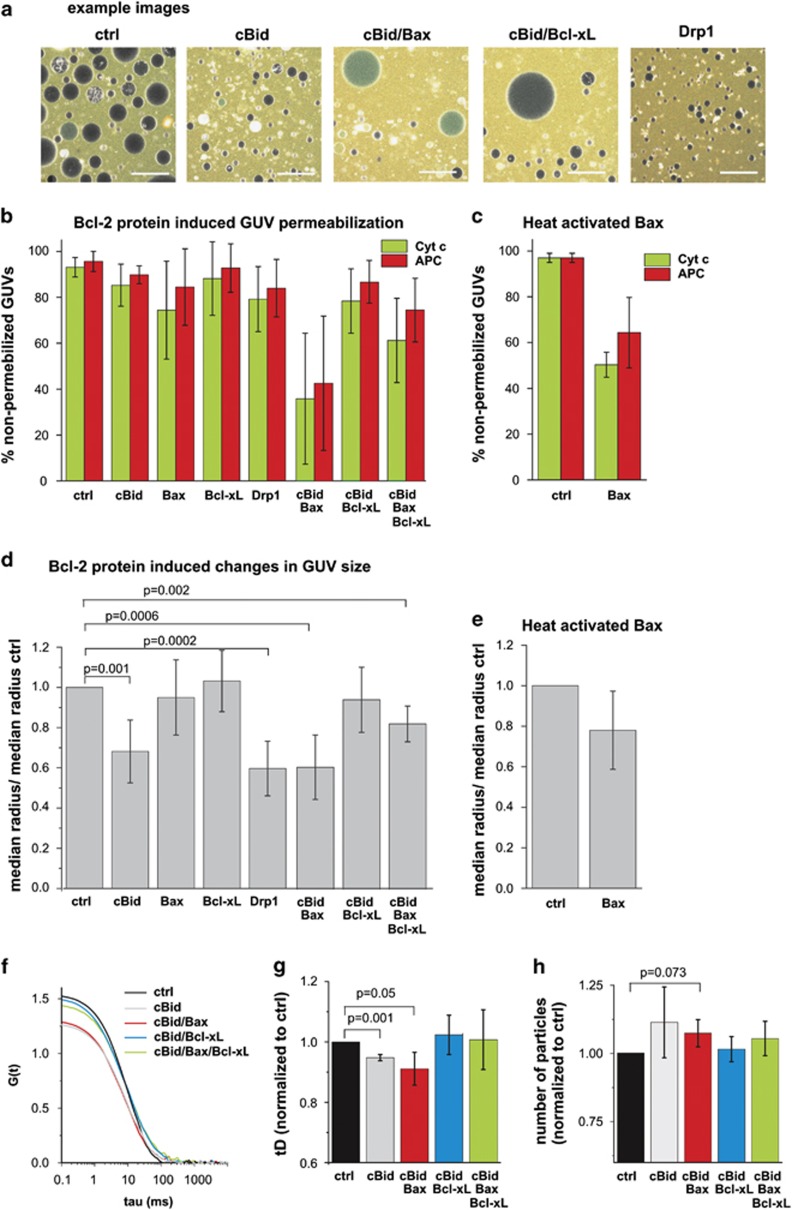
Changes in GUV size and membrane permeabilization induced by Bcl-2 proteins. (a) Representative images of GUVs (gray) in a solution of Cyt c488 (12 kDa, green) and allophycocianin (APC) (104 kDa, red) incubated in the absence (ctrl) or in the presence of 10 nM cBid, 20 nM Bax, 50 nM Bcl-xL, 10 nM Drp-1 or combinations of these proteins. Scale bar: 75 μm. (b and c) Fraction of non-permeabilized GUVs in the control sample or in presence of the indicated proteins or protein mixture (b) or after heat treatment (c). Green and red bars correspond to Cyt c488 and APC, respectively. (d and e) Comparison of the median GUV radius from the experiments introduced in (b and c) normalized to the median radius of the control sample (4.97±1.07 μm). (d) Results for individual proteins or protein mixtures. (e) Results from heat-treated samples. In each of four independent experiments, a minimum of 200 vesicles were analyzed per condition. Error bars represent the S.D. (f–h) Fluorescence correlation spectroscopy experiments on vesicle diffusion after 2 h incubation in buffer or with the indicated Bcl-2 proteins. Error bars present the S.D. (f) Auto-correlation curves from one exemplary experiment. The color code is indicated within the figure. (g and h) Comparison of the vesicle diffusion times (tD) (g) and particle numbers (h) from three independent experiments normalized to the tD or particle number of the control vesicles. Error bars correspond to the S.D. To achieve the tD a 3D fit was used